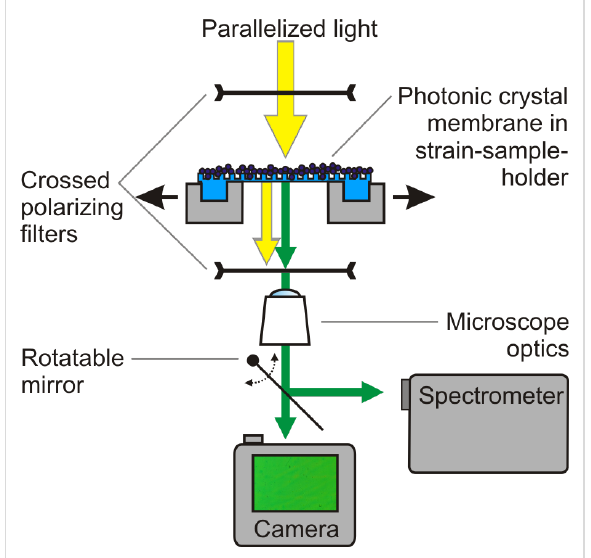
Figure 8: The measurement setup consists of a transmission light microscope with crossed polarization filters before and after the sam- ple for background suppression. The groves of the sample have a 45° angle to both polarization directions. The sample holder allows for an adjustable strain of up to